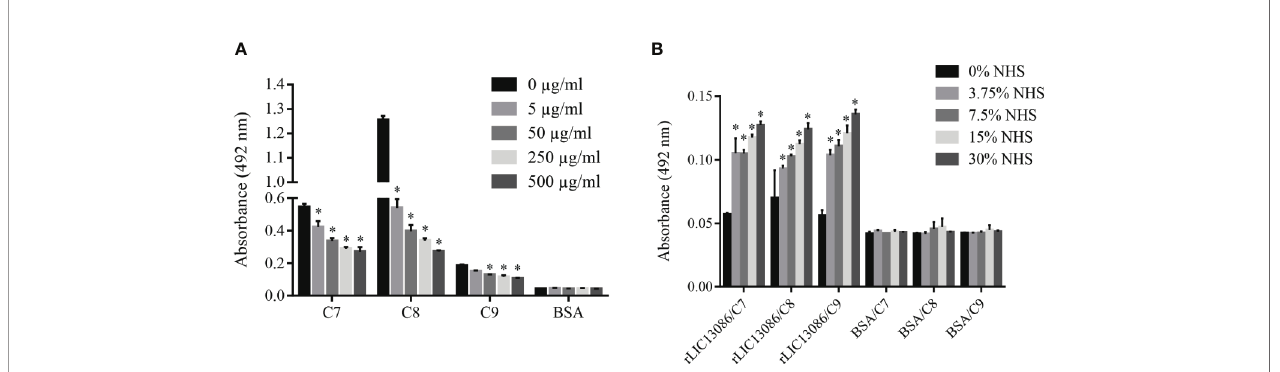
FIGURE 9 | Characterization of rLIC13086 interaction with complement system components. (A) rLIC13086 immobilized was co-incubated with C7, C8, or C9 (1 m g) and different concentrations of heparin (0 – 500 m g/ml) for 2 h at 37°C. Detection was performed with HRP-conjugated anti-HisTag mAb (1:10,000). (B) rLIC13086 was immobilized and incubated with increasing concentrations of NHS. The interaction was assessed by the addition of each goat anti-human complement component (1:10,000) followed by HRP-conjugated anti-goat IgG (1:50,000). BSA was used as negative control. The bars represent the means of three different experiments in triplicates with the corresponding standard deviation. * Indicates signi fi cant difference calculated by Student t- test with p-values <